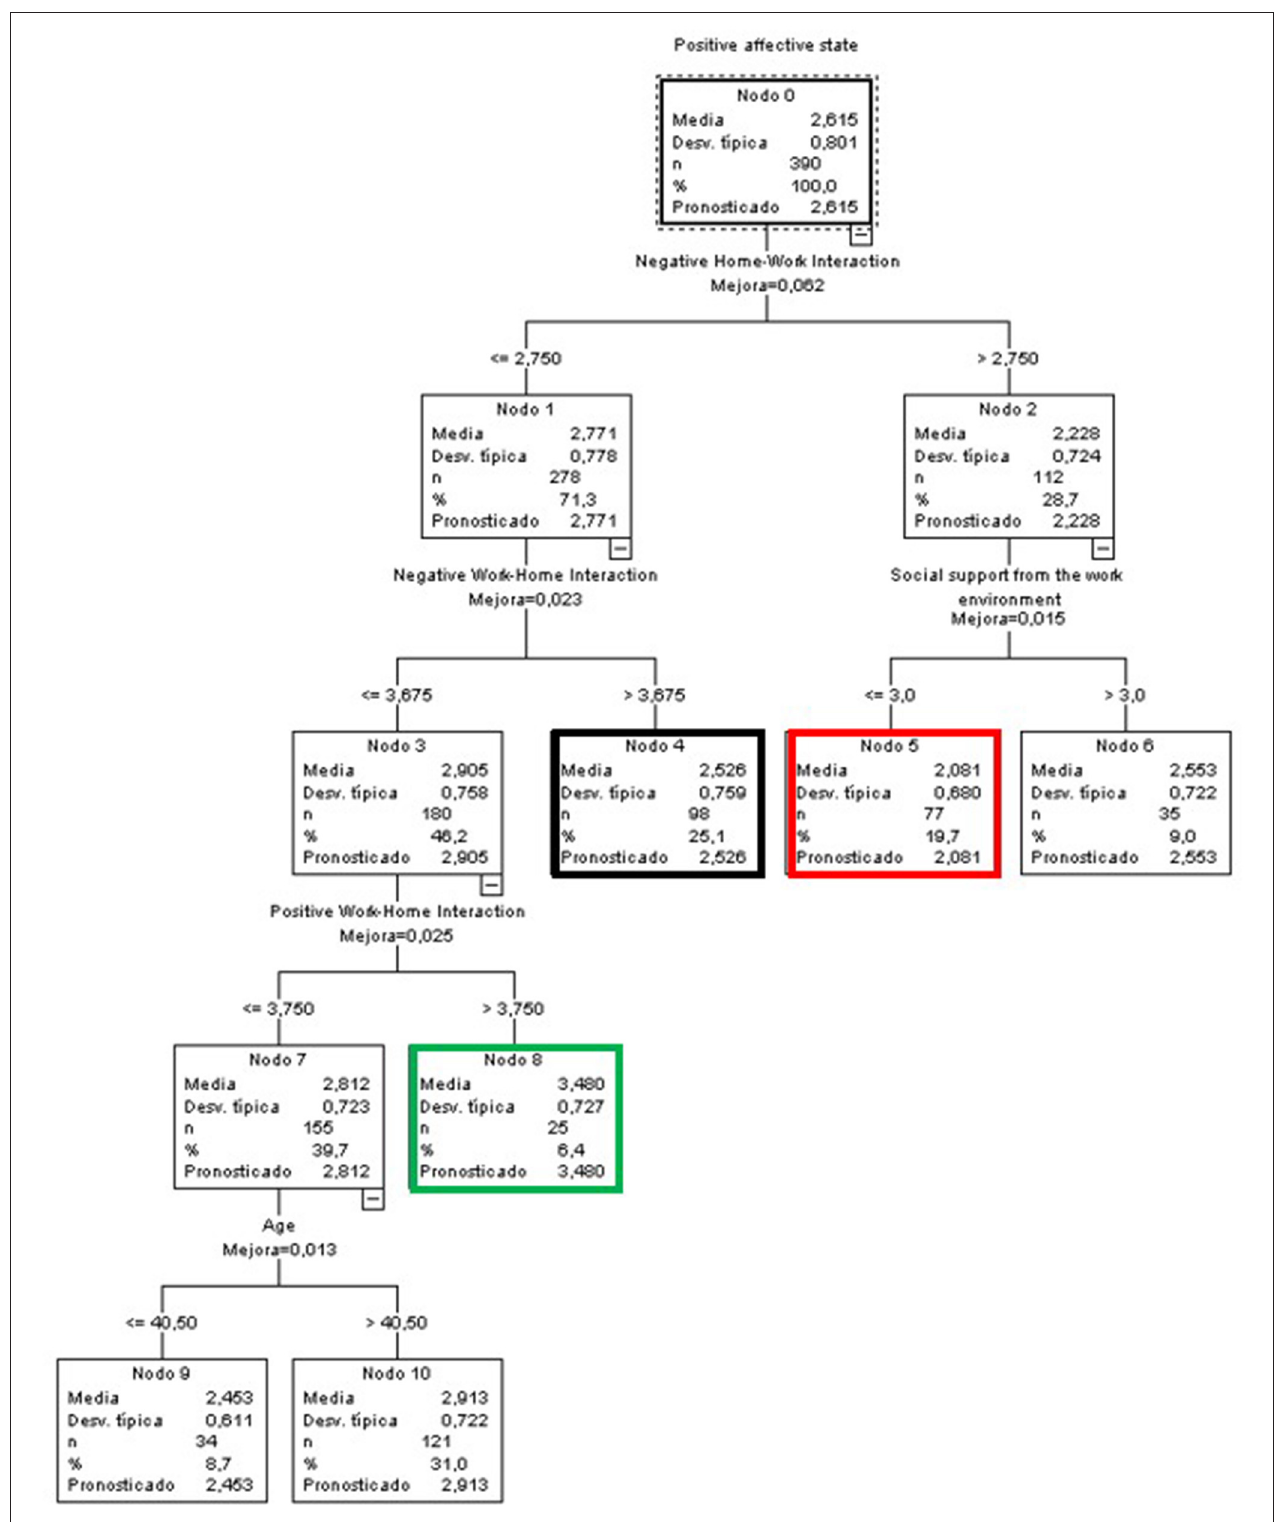
FIGURE 12 | Classificatory tree of positive affective states (T&R).